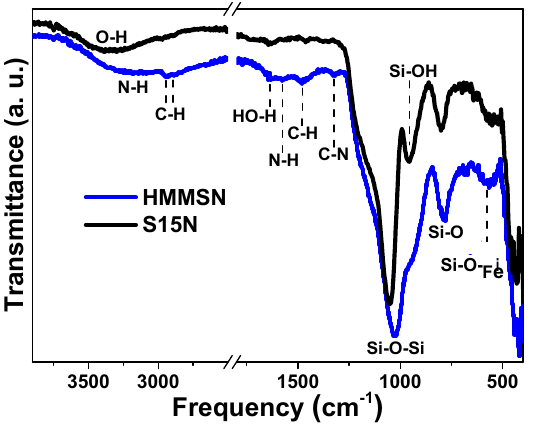
Figure 3. FTIR spectra of the S15N mesoporous silica matrix and HMMSN hybrid magnetic mesoporous nanorods.